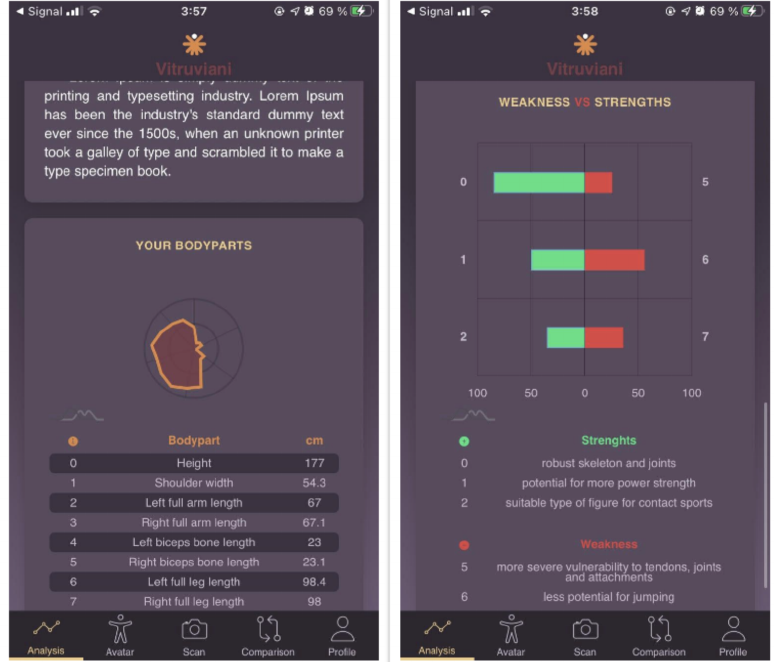
Figure 9. Basic analysis page of the scanned